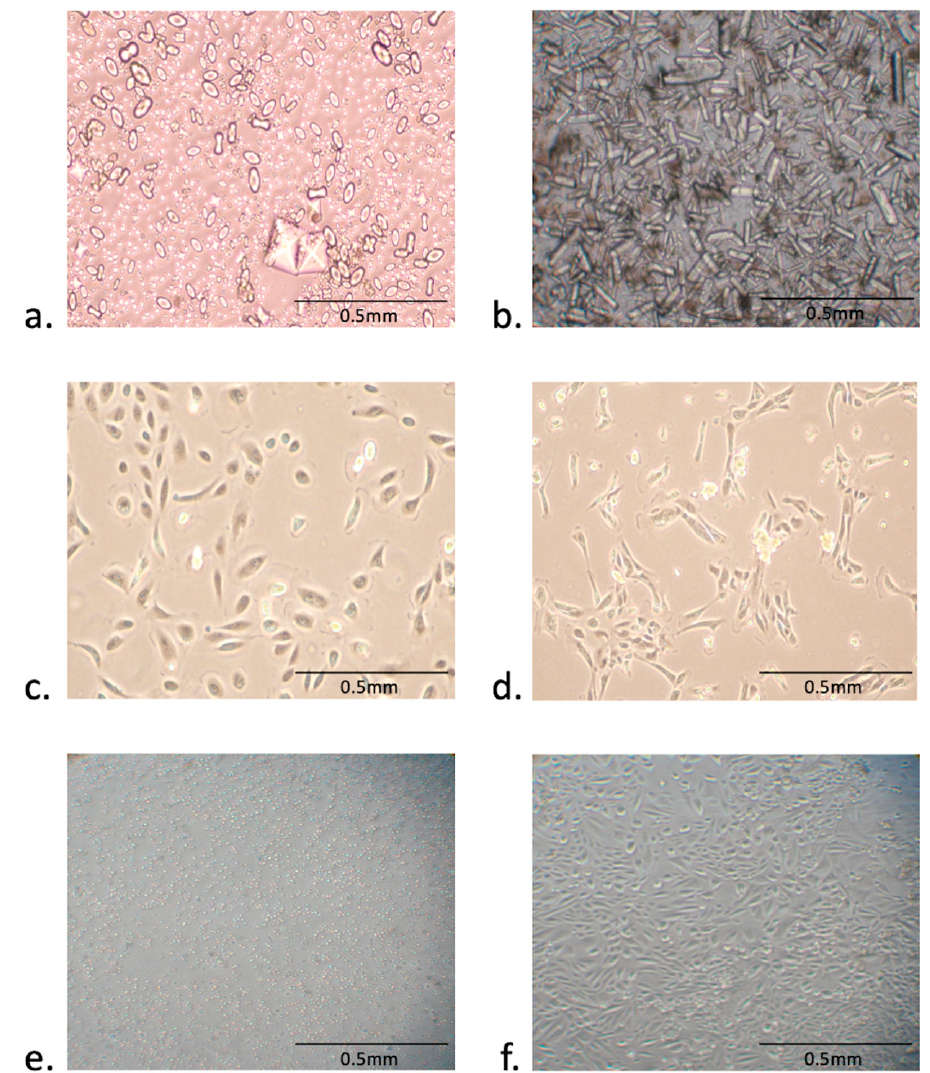
Figure 6. Factors a ff ected urine-derived epithelial cells ( a , b ). Representation of high debris in the urine Figure 6. Factors affected urine-derived epithelial cells a . and b . Representation of high debris in the samples of FXS patients. ( c , d ) Plate coating material impacts the growth and morphology of epithelial urine samples of FXS patients. c ., and d . Plate coating material impacts the growth and morphology cells. Normal growth on iMatrix coated plates ( c ) v / s distorted mesh-like growth pattern of cells on Poly L-lysine ( d – f ) Urine storage conditions a ff ect the growth of the derived epithelial cells. No cell of epithelial cells. Normal growth on iMatrix coated plates ( c .) v/s distorted mesh-like growth pattern growth was observed from the urine samples stored for 24 h at − 20 ◦ C before isolating cells ( e ) as of cells on Poly L-lysine ( d ). e . and f . Urine storage conditions affect the growth of the derived compared to freshly collected and processed urine samples ( f epithelial cells. No cell growth was observed from the urine samples stored for 24 h at − 20 °C before isolating cells ( e ) as compared to freshly collected and processed urine samples ( f ).